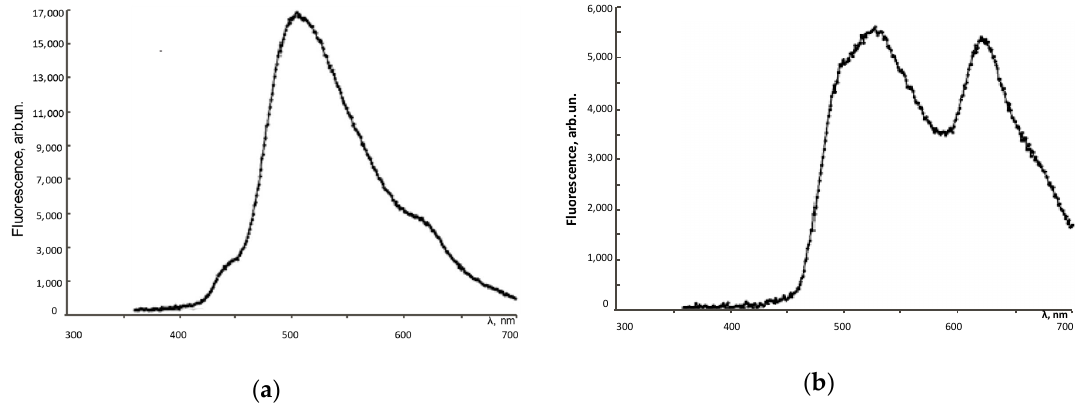
Figure 2. Fluorescence spectra for aqueous solutions of ( a ) FF1 and ( b ) FF2 at room temperature for the excitation at 370 nm. FF1 concentration is 178 nM; FF2 concentration is 220 nM.